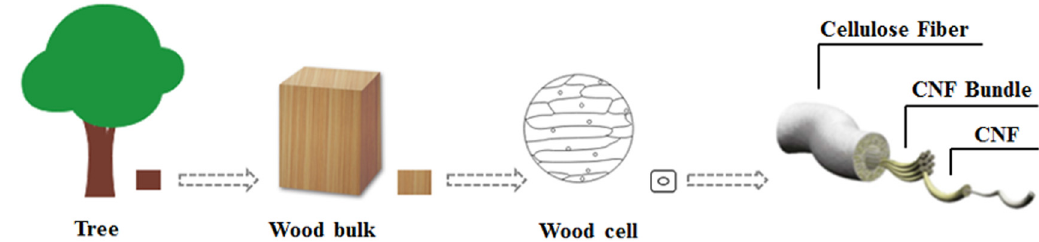
Figure 1: Hierarchical structure of cellulose.